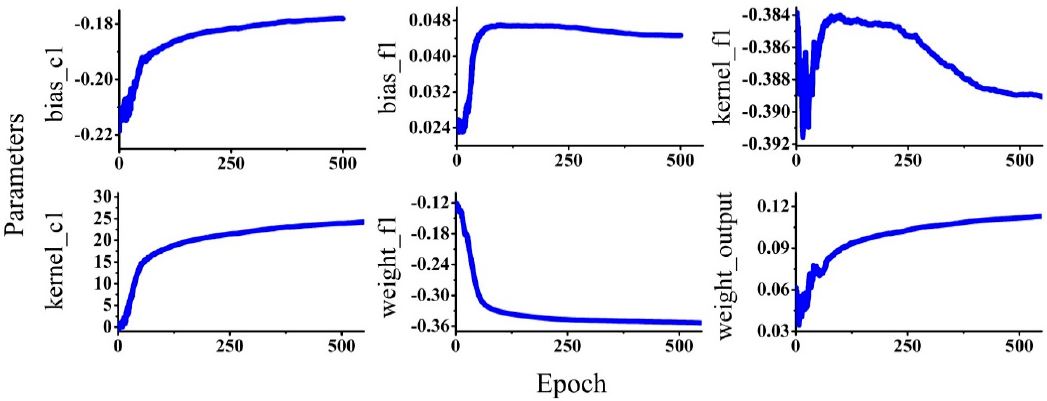
Figure 11. Convergence process of the convolutional neural network model parameter. Table 5. Parameter values under different epoch times.